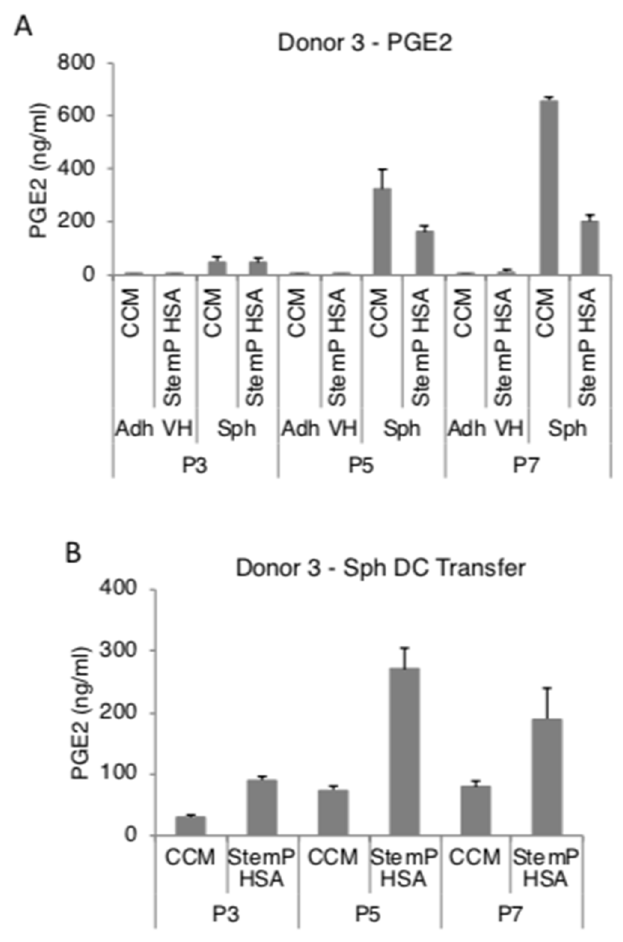
Figure 4. Spheroids generated from extensively expanded MSCs secrete high amounts of prostaglandin E2 (PGE2). MSCs from various passages (3, 5, and 7) were cultured as spheroids and as very high density monolayers in fetal bovine serum (FBS)-containing and xeno-free media. The conditioned medium was harvested for PGE2 ELISA. Spheroids were also dissociated and the resulting cells were tested for their ability to maintain PGE2 secretion. ( A ) PGE2 secretion by spheroids and very high density monolayer MSCs in FBS-containing media and xeno-free media at di ff erent passages. ( B ) PGE2 secretion by spheroid-derived cells from FBS-containing media and xeno-free media at different passages. Abbreviations: Adh VH, adherent very high density monolayer MSCs; CCM, complete culture medium; P3, passage 3; Sph, spheroid MSCs; Sph DC, spheroid- derived MSCs; StemP HSA, StemPro xeno-free media with human serum albumin.